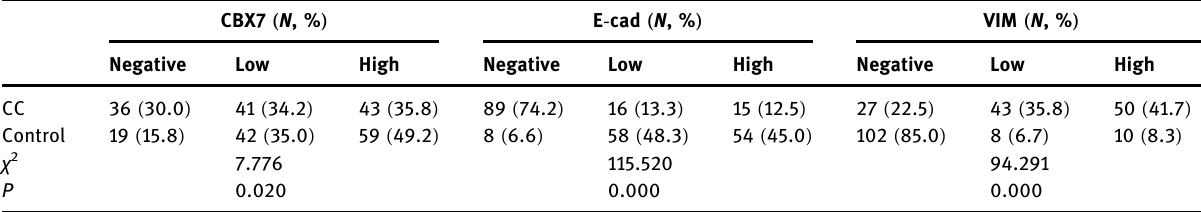
Table 3: Expression of CBX7, E - cad, and VIM in CC and adjacent non - tumorous cervical